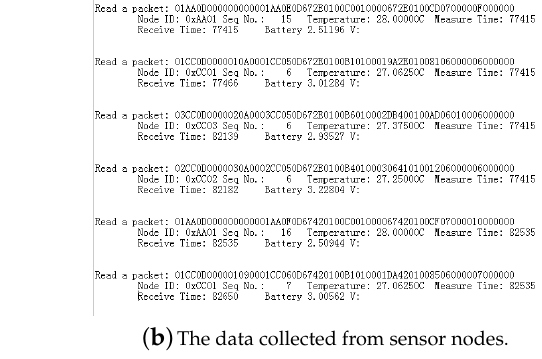
Figure 10. The structure of the IT-WSN and the data process on the